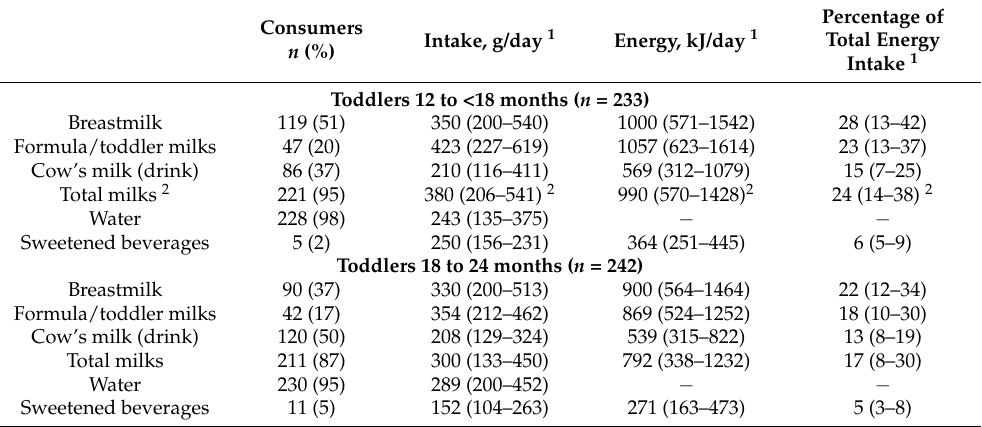
Table 6. The percentage of total energy from drinks for toddlers stratified by age, OzFITS